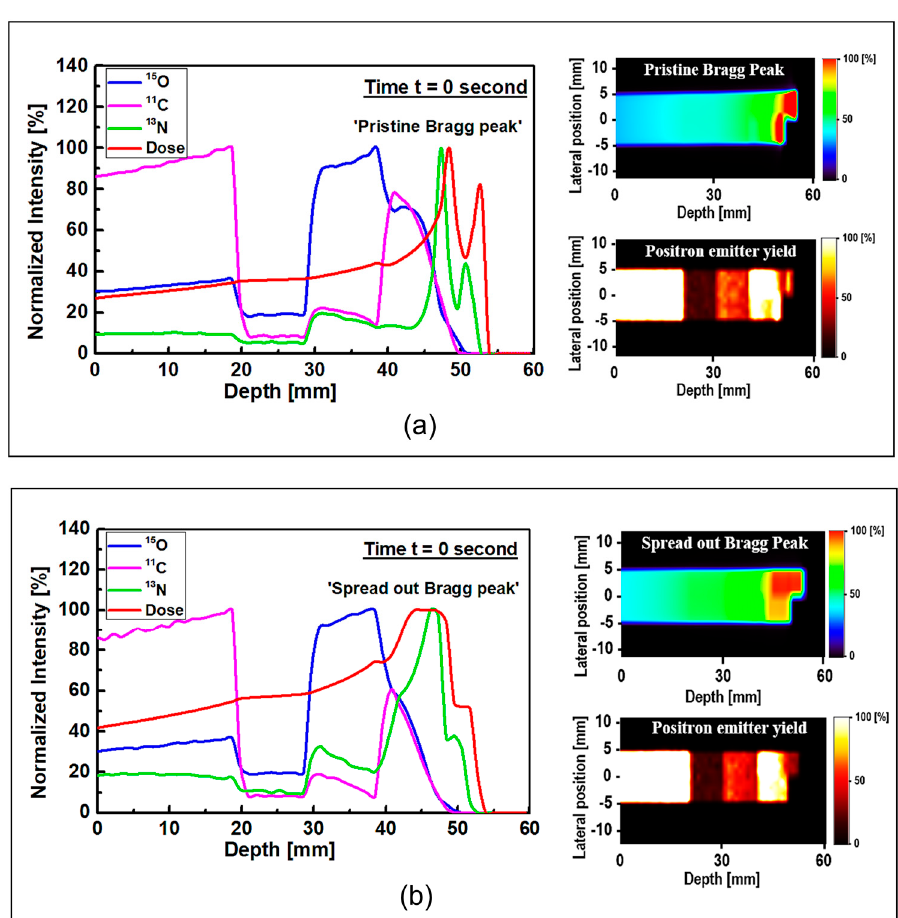
Figure 4. The 1D and 2D profiles of the simulated depth-dose of protons and production of positron emitting radionuclides ( 15 O, 11 C and 13 N) in ordinary slab phantom for ( a ) pristine and ( b ) SOBP incident proton beams.